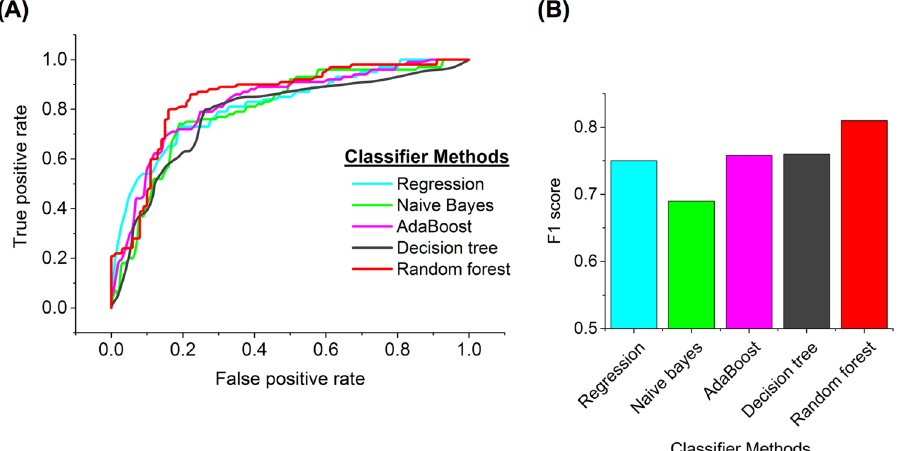
Figure 3. Performance of different classifiers. ( A ) Receiver operating characteristic (ROC) curves for five commonly-used classifier methods. Inputs for the classifiers utilized the full linguistic and cognitive profiles of FX premutation carriers and the comparison group. ROC curves provide a comprehensive visualization to summarize accuracy of prediction methods. The diagram shows a test’s false-positive rate (FPR), or 1 – specificity versus its sensitivity. ( B ) F1 score measures the test’s accuracy. It considers both precision and recall. As the F1 score approaches 1, the test has better accuracy. Random forest has F1 score equal to 0.81, which indicates the best performance among the tested classifiers.